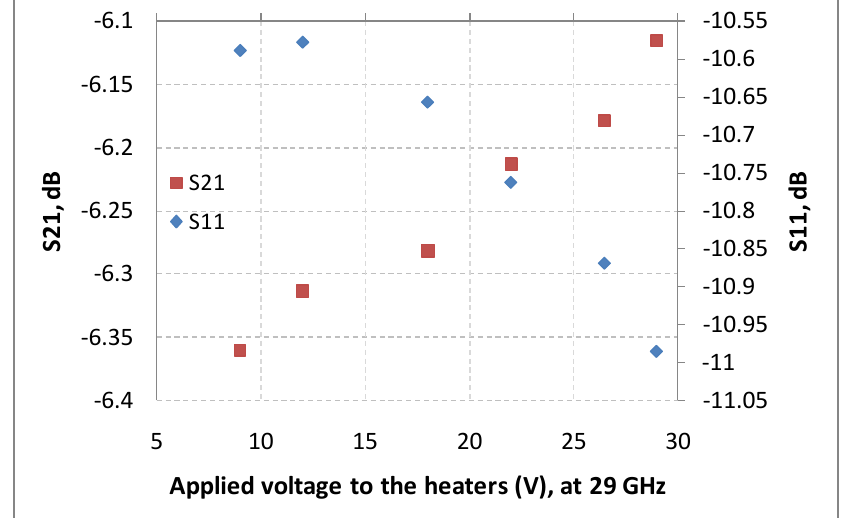
Figure 13. scattering parameters vs. applied voltage to the heaters, f = 29 GHz.